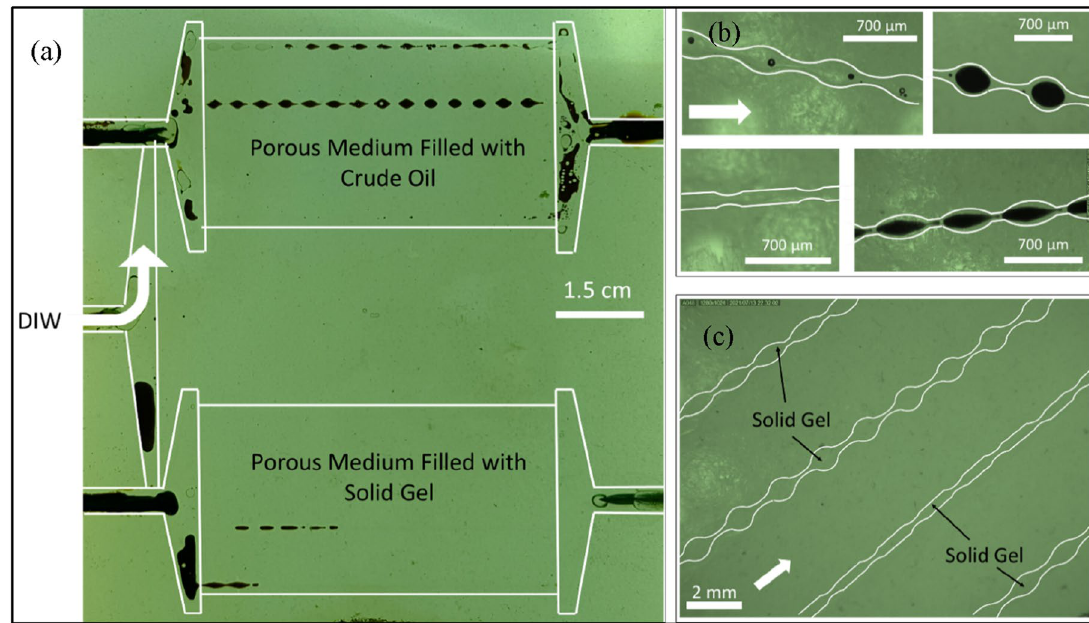
Figure 15. ( a ) Macroscopic image of the whole micromodel, ( b ) microscopic image of the top oil-saturated porous medium, and ( c ) microscopic image of the bottom gel-saturated porous medium. The images have been taken after 2 PV injection of DIW into the dual-patterned glass micromodel initially saturated with crude oil (top porous medium) and a solid gel formed from 3 wt% silica + 3 wt% NaCl in DIW after 24 h (bottom porous medium). The letter “t” shows the time of flooding. The white arrow shows the flow direction.